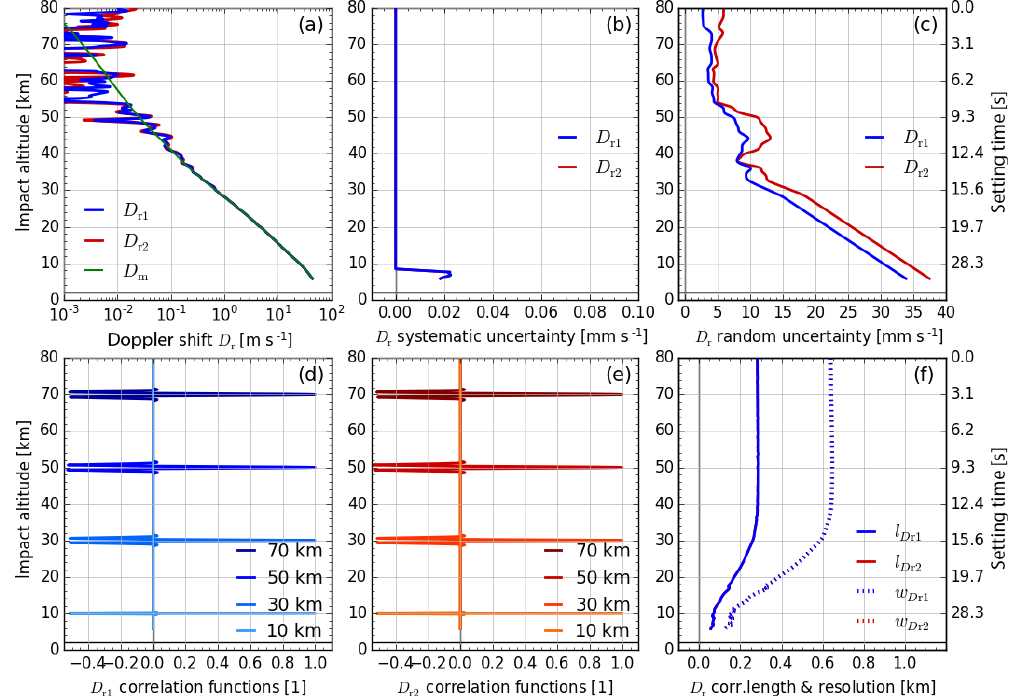
Figure 5. Results for retrieved Doppler shift profiles D r (with model profile D m for comparison) in panel (a) , estimated systematic uncer- tainty profiles u s in panel (b) , estimated random uncertainty profiles u r in panel (c) , representative correlation functions R D r ,i (at 10, D r D r 30, 50, and 70km) in panels (d) and (e) , and correlation length l D r (solid) and resolution profiles w D r (dotted, estimated for main peak) in panel (f) . All profiles are shown for both GPS carrier frequencies: f T1 (blue) and f T2